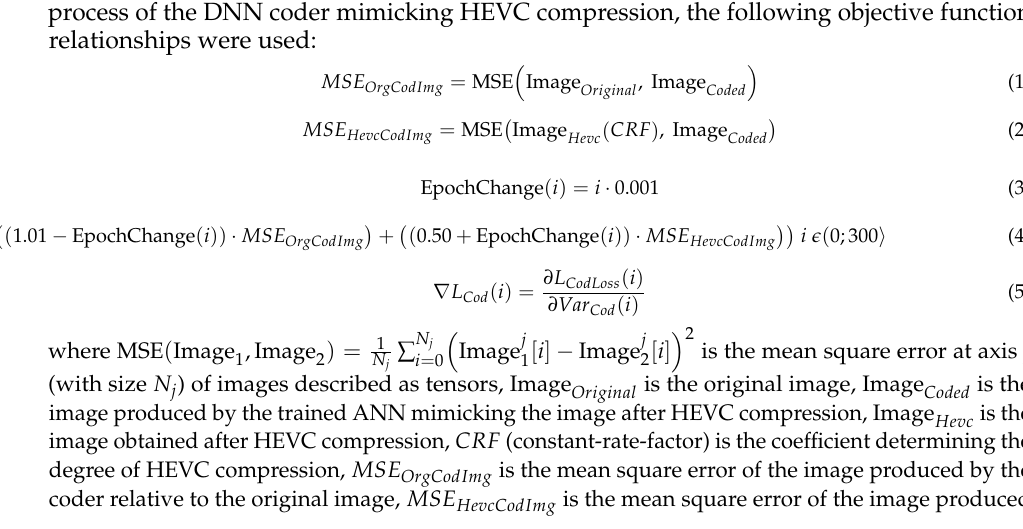
Figure 2. Demonstration of YUV color model for the YUV444 and YUV420p